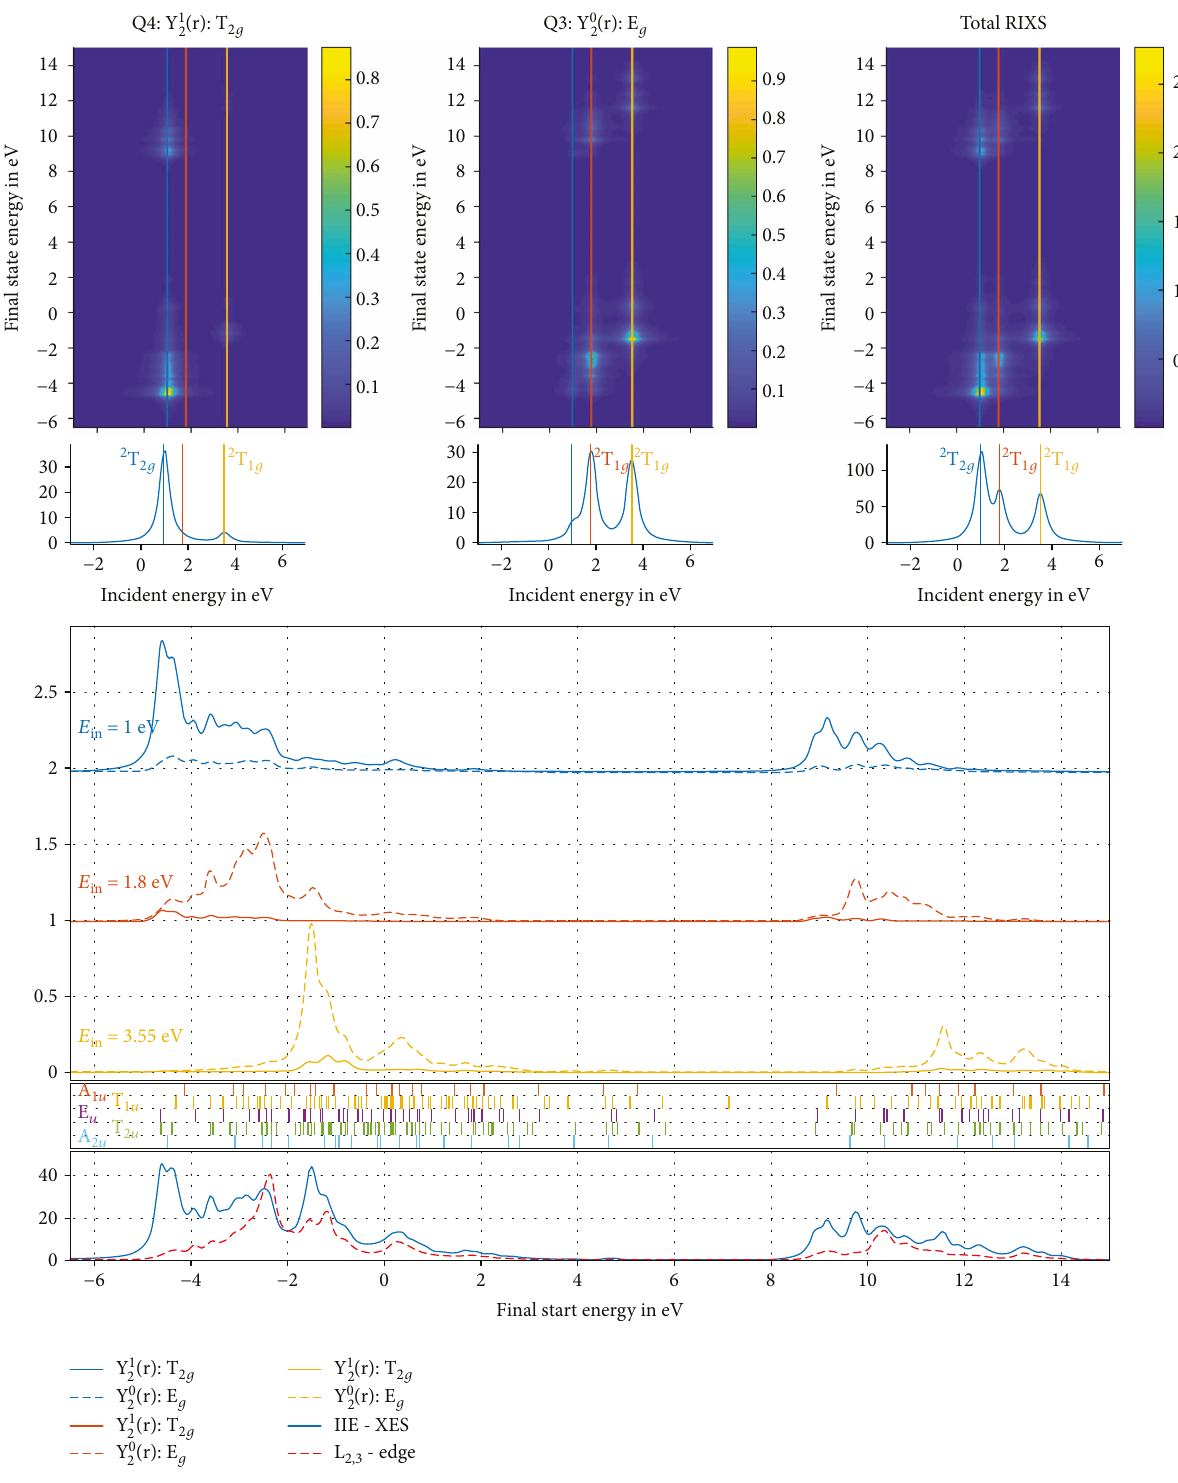
Figure 47: Calculated 1s2p RIXS spectra and slices for Fe 2+ ( 3d 6 ) for 10D q = 0 9eV (high analogue to the Tanabe-Sugano diagram of 3d 8 . The The intermediate state electron con fi guration is 1s 1 3d 8 ( 2 ⋅ 45 = 90 microstates). The atomic terms are 2 , 4 F , 2 , 4 P , 2 S , spin-conserving 1s XAS reaches only spin quartet intermedi- 2 D , and 2 G (Table 1). Using Table 2, one fi nds the branch- ate states, which corresponds to the crystal fi eld terms issued from 4 F and 4 P: 4 A , 4 T , 4 T , and 4 T , respectively. ings of the atomic states in an O crystal fi eld which are 2 g 2 g 1 g 1 g h